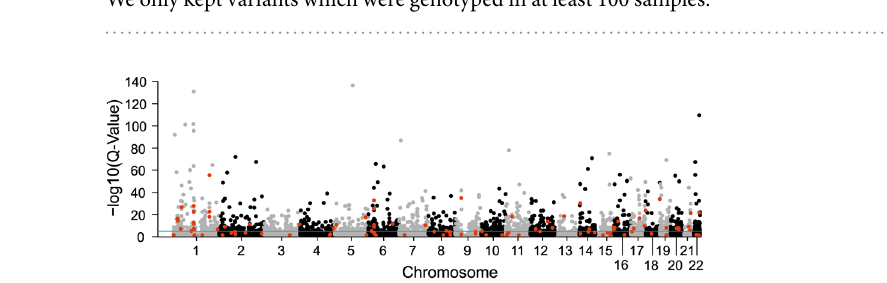
Table 1. Study and sample summary QC = quality control; a Omni 2.5 M for the first data release (GTEx start) and Omni 5 M for the mid-point release (GTEx mid). b After quality control the genotype files of the four studies were merged into a single file and variants, which did not overlap in-between datasets, were assigned missing. We only kept variants which were genotyped in at least 100 samples.